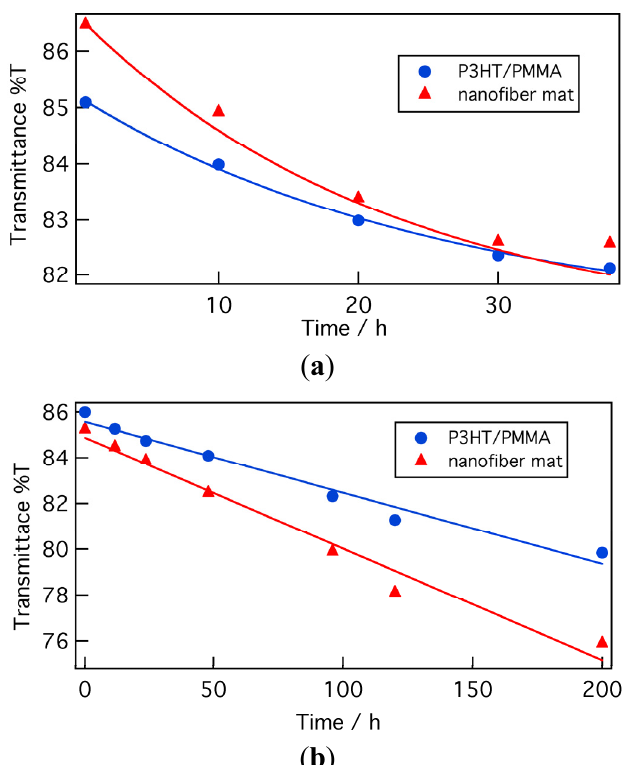
Figure 7. Time dependence of the transmittance at the peak absorbance wavelength (nanofiber mat: 554.5 nm, nanofiber composite film: 514 nm) of a nanofiber mat and a P3HT/PMMA nanofiber composite film before and after doping by ( a ) FeCl Measurements were carried out, in air, at room